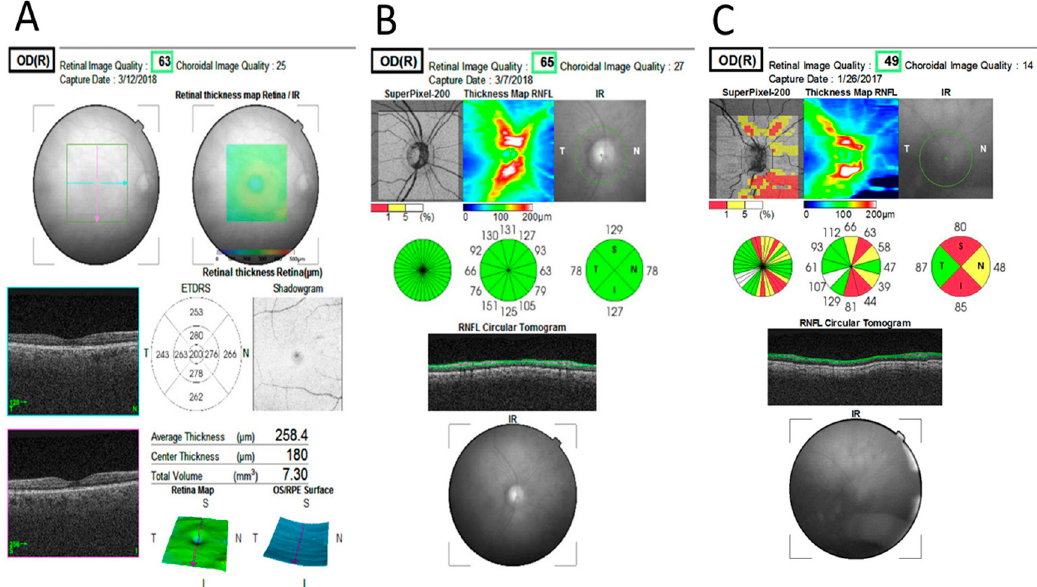
Figure 3. Examples of macular and optic nerve optical coherence tomography (OCT) printouts. ( A ) Normal macula with total retinal thickness displayed on the early treatment diabetic retinopathy study (ETDRS) map; ( B ) normal optic nerve retinal nerve fiber layer OCT-thickness map printout. Normal values (green colored) are displayed in all optic nerve quadrants; ( C ) abnormal optic nerve retinal nerve fiber layer OCT-thickness map printout displaying severe thinning in the superior and inferior quadrants (red) and moderate thinning in the nasal quadrant (yellow). Notice the relative perseverance of the temporal quadrant (green).